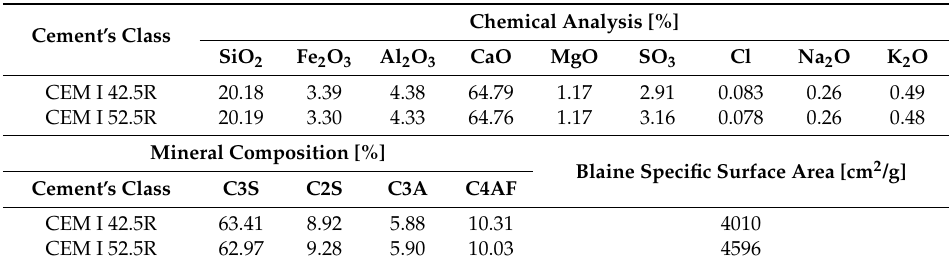
Table 1. Characteristics of the Portland cements